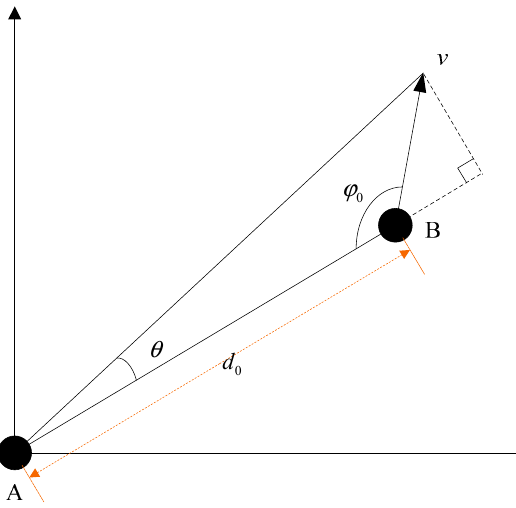
Figure 1. Schematic diagram of interference and receiver dynamic motion model.